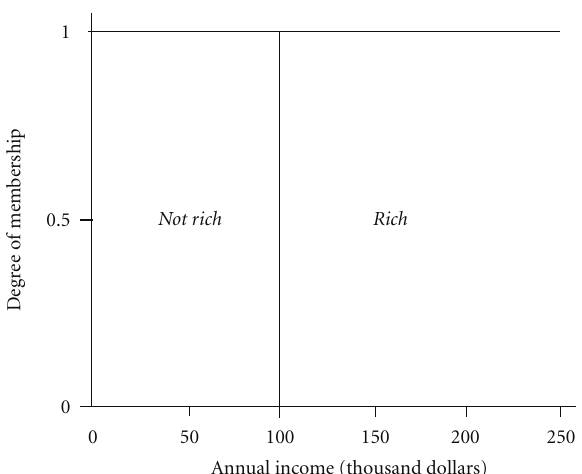
Figure 2: Warren’s crisp sets for rich and not rich with his dividing line of $100,000.